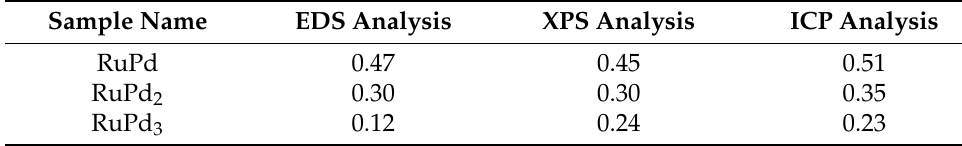
Table 1. The element analysis (Ru content) of RuPd, RuPd 2 and RuPd 3 Ans. Sample